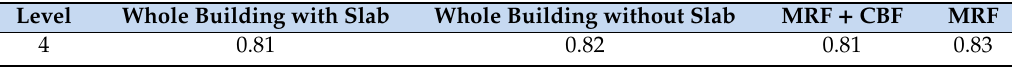
Table 5. Maximum inter-storey drift for KHC and IHC models for the ULS case (%). Level Whole Building with